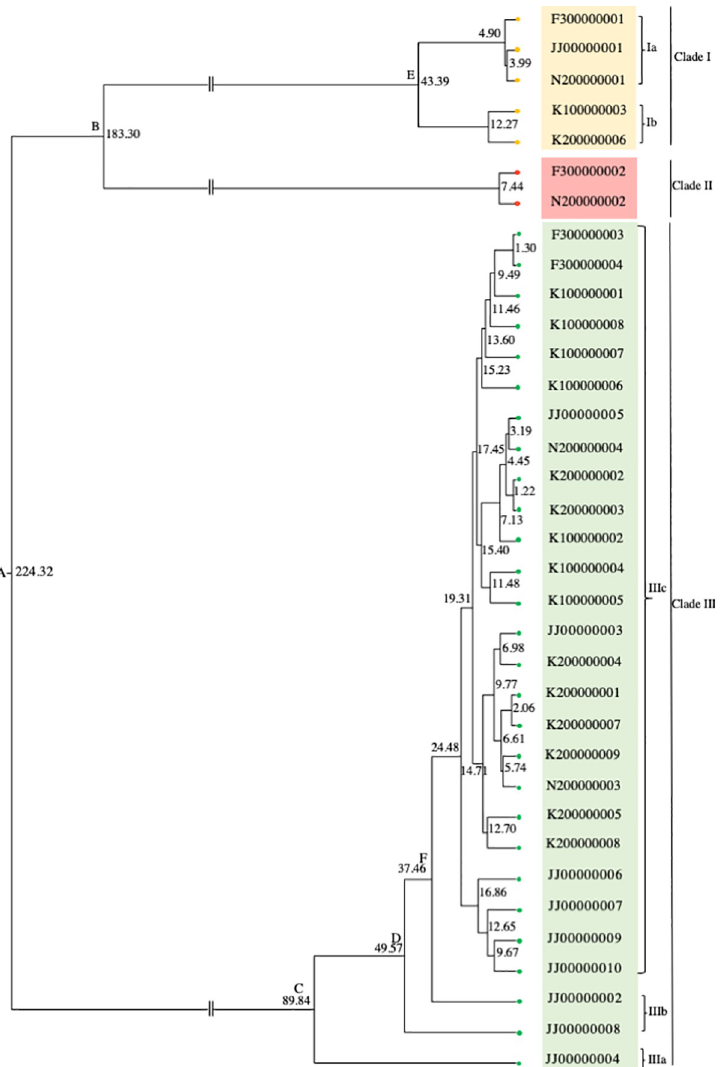
Fig 5. Divergence-time estimation of BtAdV based on the nucleotide-substitution rate per site per year of the hexon gene of HAdV-7. The time-scaled phylogenetic tree summarizes all MCMC phylogenies of the hexon gene data set, analyzed under HKY+G and Coalescent constant size models in BEAST software, version 2.6.0. The number at each node indicates the divergence time (years